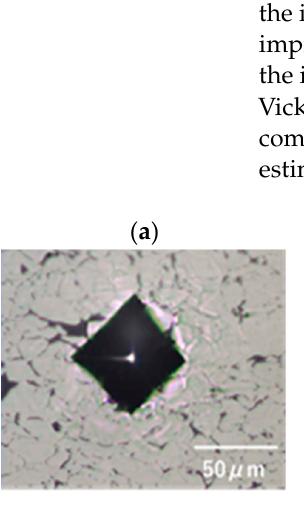
Figure 11. Optical microscope images of residual indentation impressions for micro Vickers hard- ness ( a ) and nanoindentation ( b , c ). ( a ) is impression for Micro Vickers hardness, ( b ) is impression for Nanoindentation (in SUS304 phase), ( c ) is impression for Nanoindentation (in ZrO 2 phase).